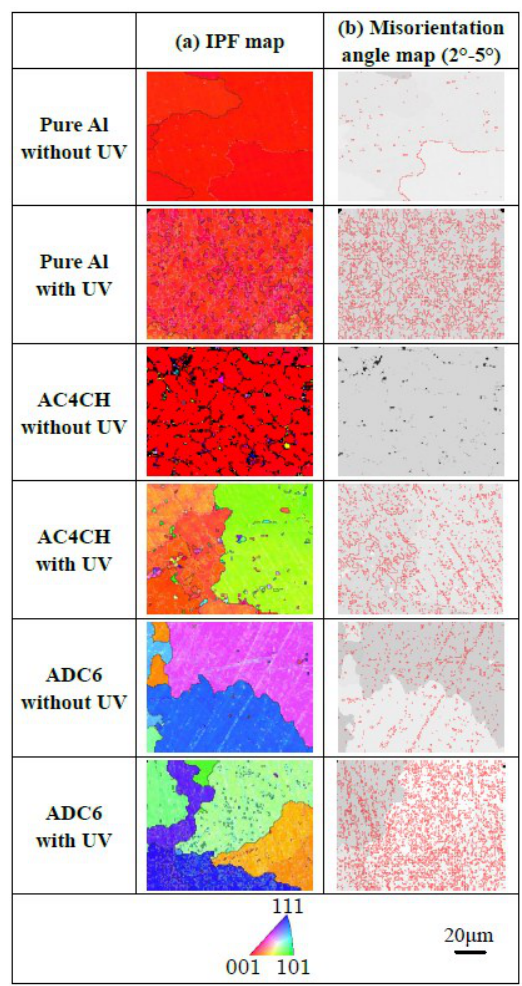
Figure 3. Electron backscatter diffraction (EBSD) analysis of pure aluminum, AC4CH and ADC6 with and without ultrasonic vibration process: ( a ) crystal orientation maps (IPF) and ( b ) misorientation angle